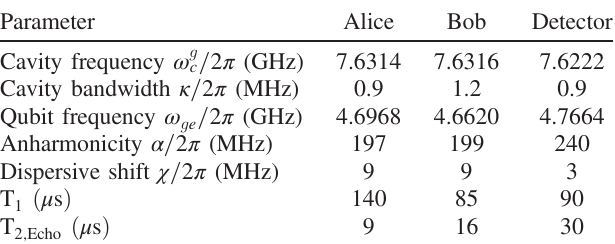
TABLE I. Alice, Bob, and detector qubit and cavity parameters.